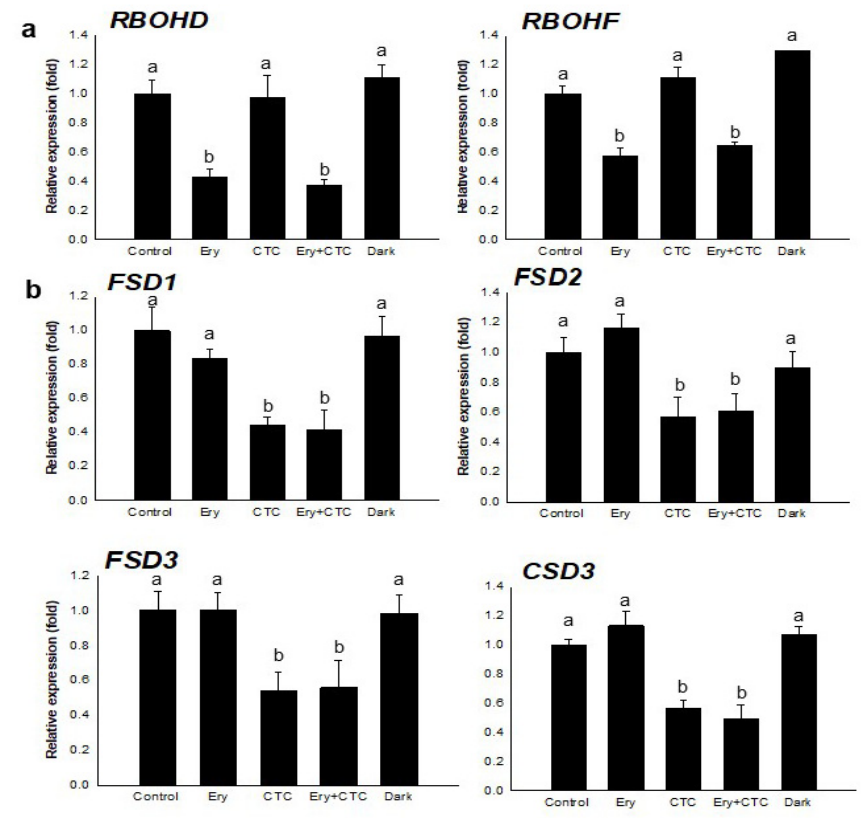
Figure 2. Effect of veterinary antibiotics on expression of RBOH and SOD genes. ( a ) Expression of RBOHD and RBOHF. ( b ) Expression of SODs : FSD1 , FSD2 , FSD3 , and CSD3. The relative expression (fold change) was determined by qRT-PCR analysis of total RNA extracted from whole B. campestris seedlings grown for 5 days under the following conditions: control, no antibiotics; Ery, 5 mg/L erythromycin; CTC, 5 mg/L chlortetracycline; Ery + CTC, 5 mg/L erythromycin and 5 mg/L chlortetracycline; dark, no antibiotics and complete darkness for 5 days. Expression of each gene was normalized against expression of the reference gene EF1a . Bars represent means ± SD ( n = 36); the experiments were replicated three times with similar results. Different letters above bars indicate a statistically significant difference within each treatment as determined by one-way analysis of variance (ANOVA) and Tukey’s honestly significant difference (HSD) test, p < 0.05.